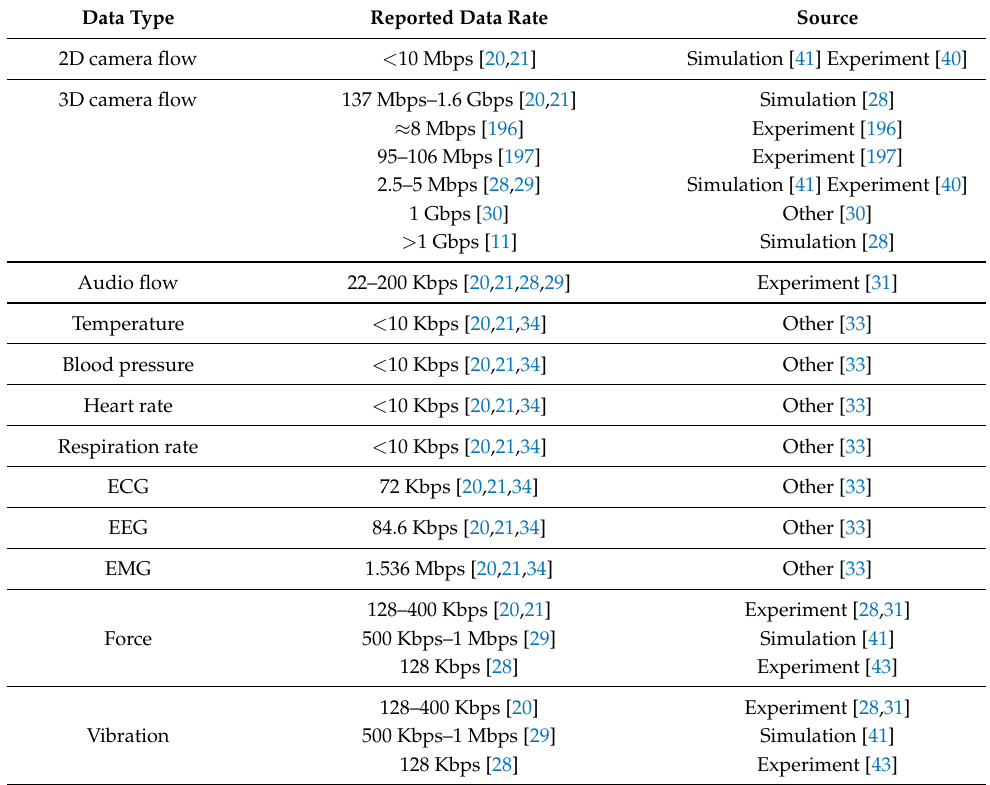
Table A3. Data rate requirements for